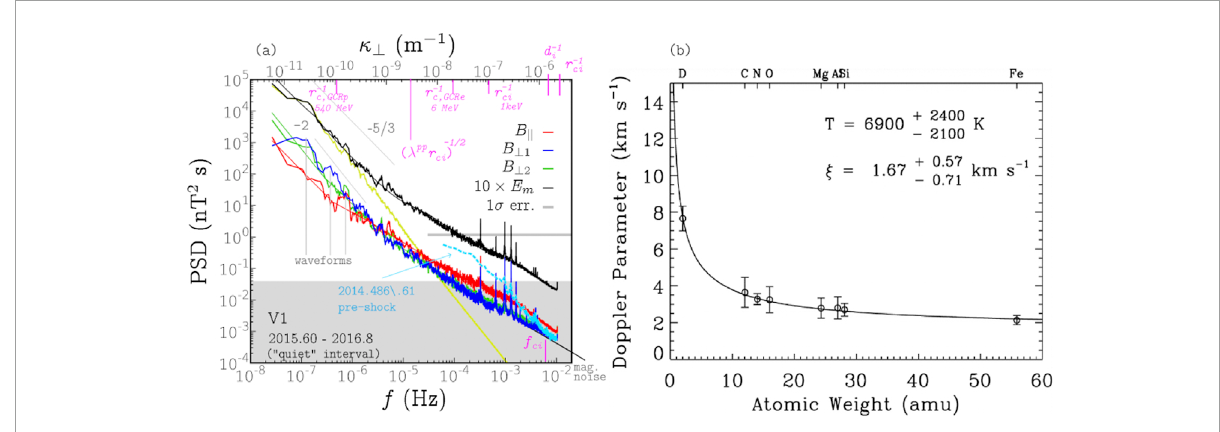
FIGURE 3 VLISM turbulence. (A) Power spectra of magnetic field fluctuations observed in situ by V1 at ∼ 135 AU from the Sun (reproduced from Fraternale et al., 2022a). (B) Turbulence properties inferred from absorption line observations (reproduced from Redfield and Linsky, 2004a).